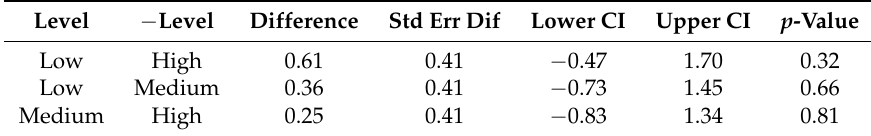
Table 7. Tukey–Kraimer comparison of multiple means. All units in